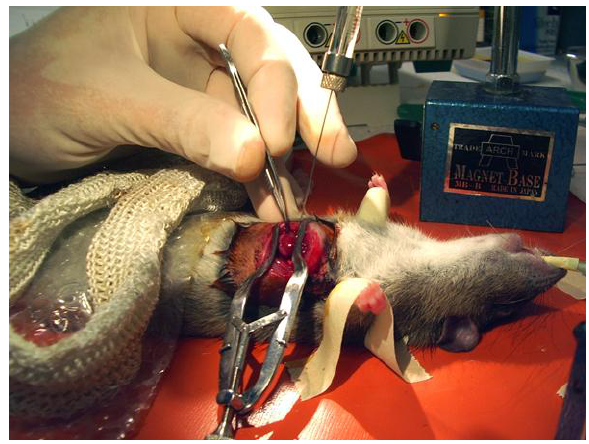
FIGURE 1. The heart was exteriorized using forceps and the main coronary artery identified. Electrocauterization was used to cut and